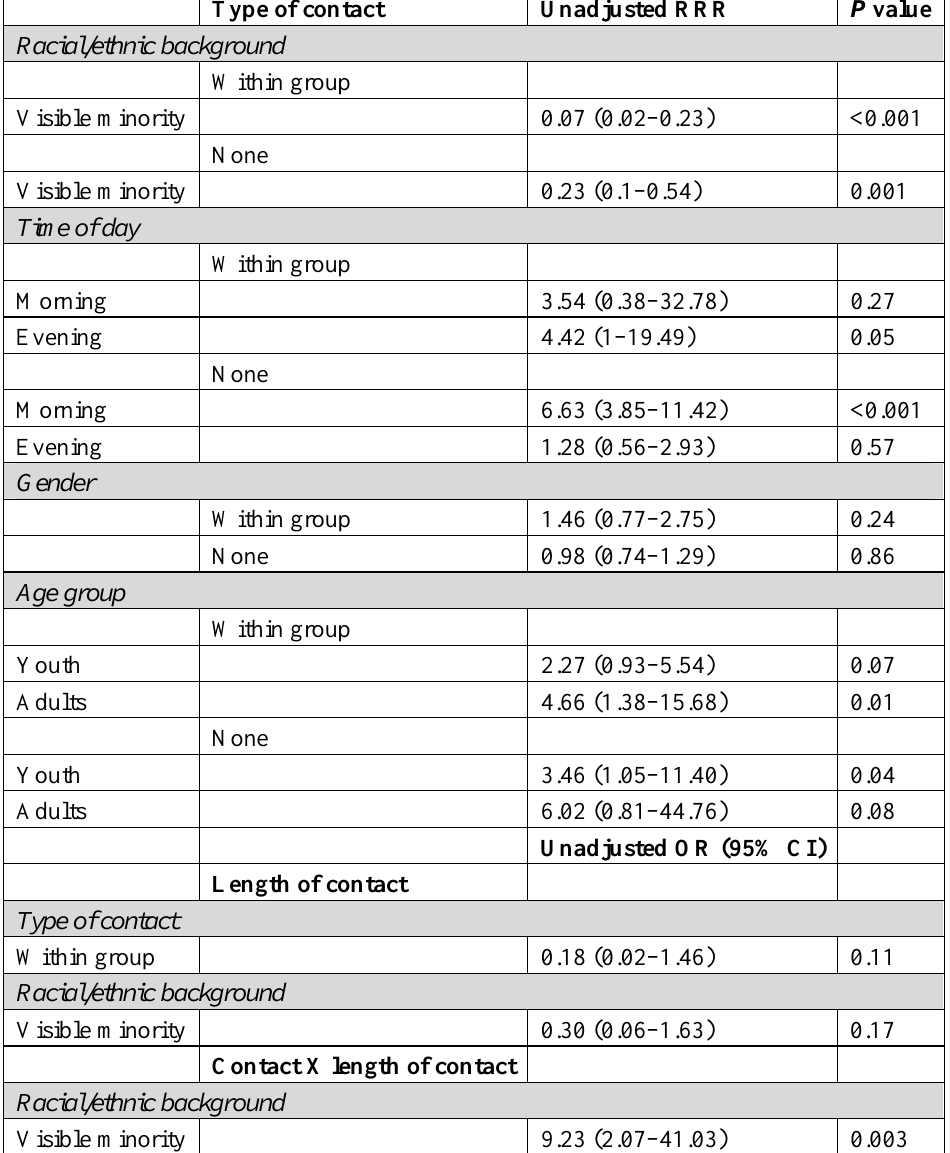
Table 2. Bivariate relationships between type of contact, length of contact, and socio-demographic